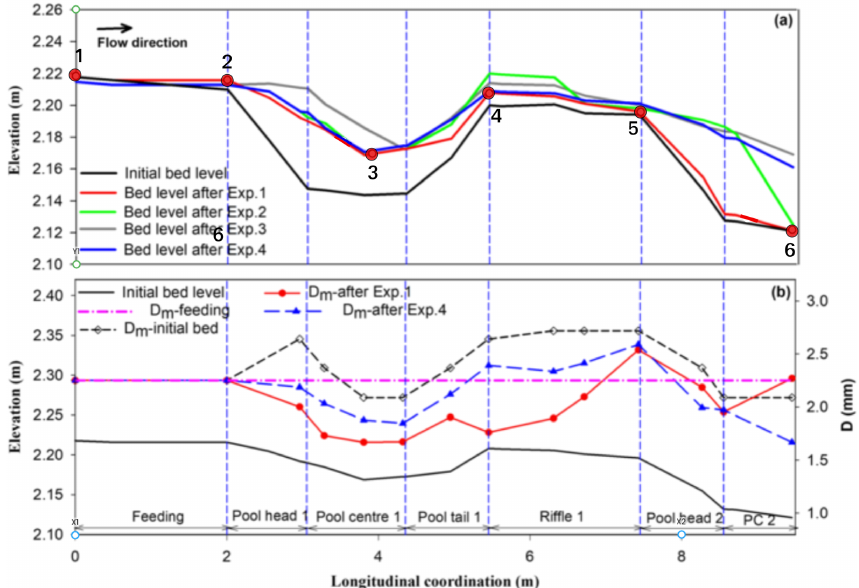
Figure B5. Modified Fig. 5 of Vahidi et al. (2020) showing the locations of channel width and elevation profile measurements indicated by the open circles. The elevation profile series is at the top of the image. Width measurements were taken from Fig. 1 of Vahidi et al. (2020). Elevation measurements were made for Experiments 1 and 4 by shifting the indicated points straight up to the Experiment 4 line where they do not overlap. Values are in meters. Flow is from left to right in the image.